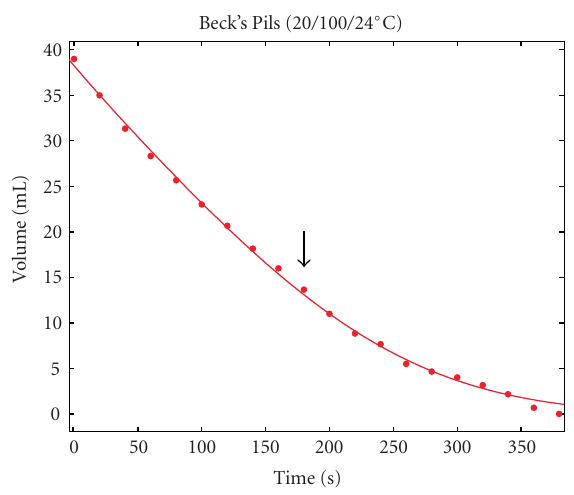
Figure 3.1. The volume of the beer foam as a function of time. The fitting function is given by (3.3). The arrow approximately indicates the point, where drainage switches to bubble rearrangement as dominating